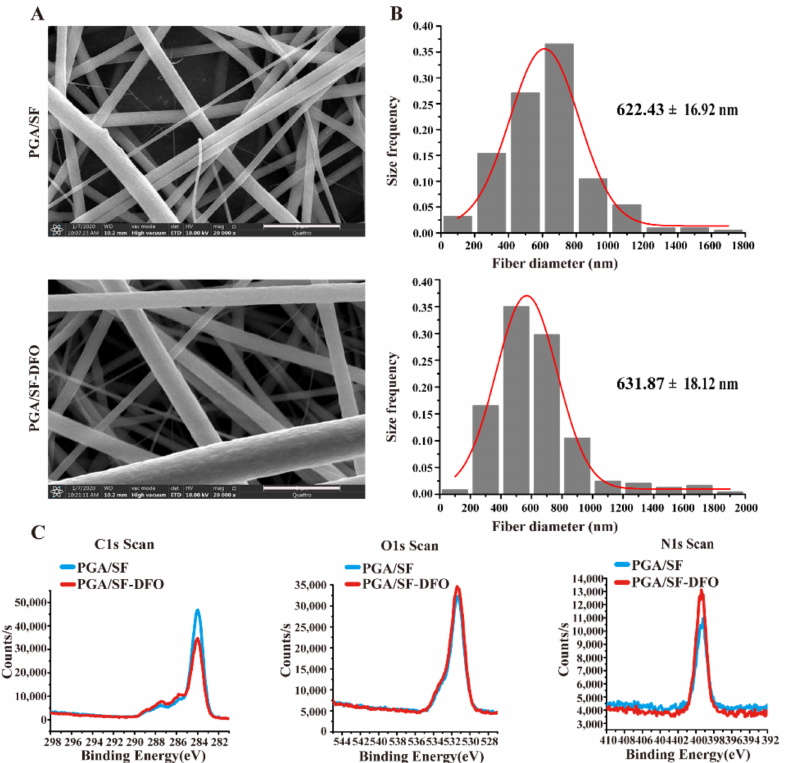
Figure 1. Characterization of PGA/SF and PGA/SF-DFO scaffolds. ( A ) SEM morphology. ( B ) The diameter distribution analysis of PGA/SF and PGA/SF-DFO scaffolds, scale bar = 5 µ m. ( C ) The element analysis of C, N, O by XPS.